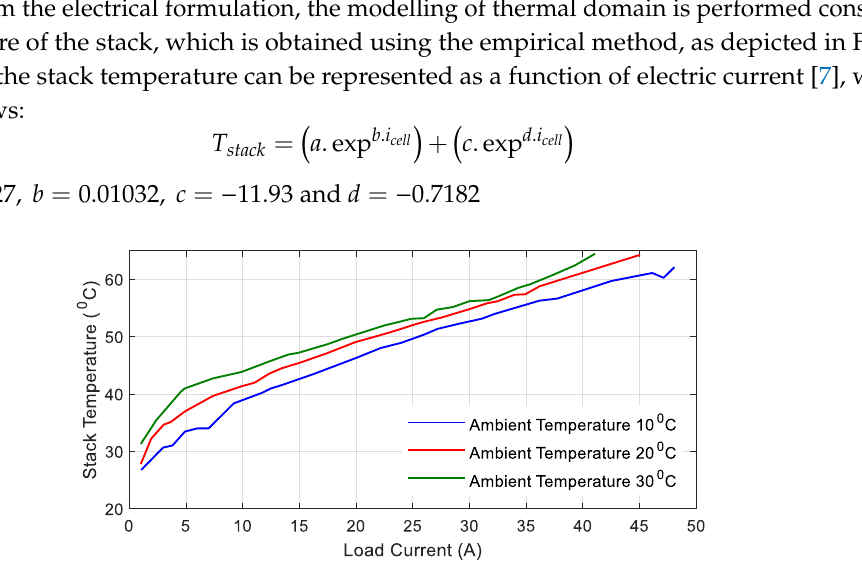
Figure 4. Temperature of the stack for load variation in MSE PEMFC.